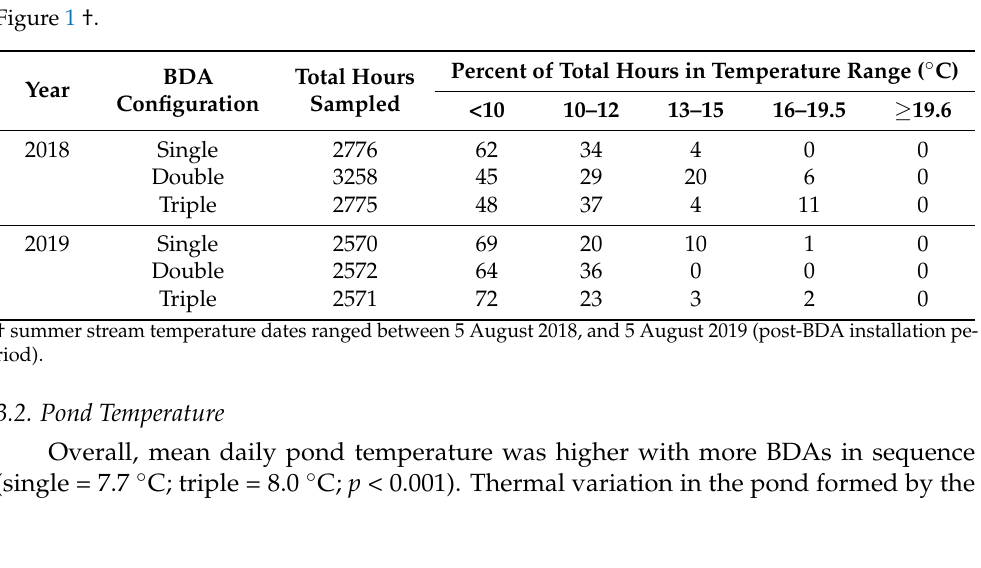
Table 2. Percent of hours summer stream temperatures fell into one of the five temperature ranges downstream of three BDA configuration series. Maximum growth temperature for bull trout is